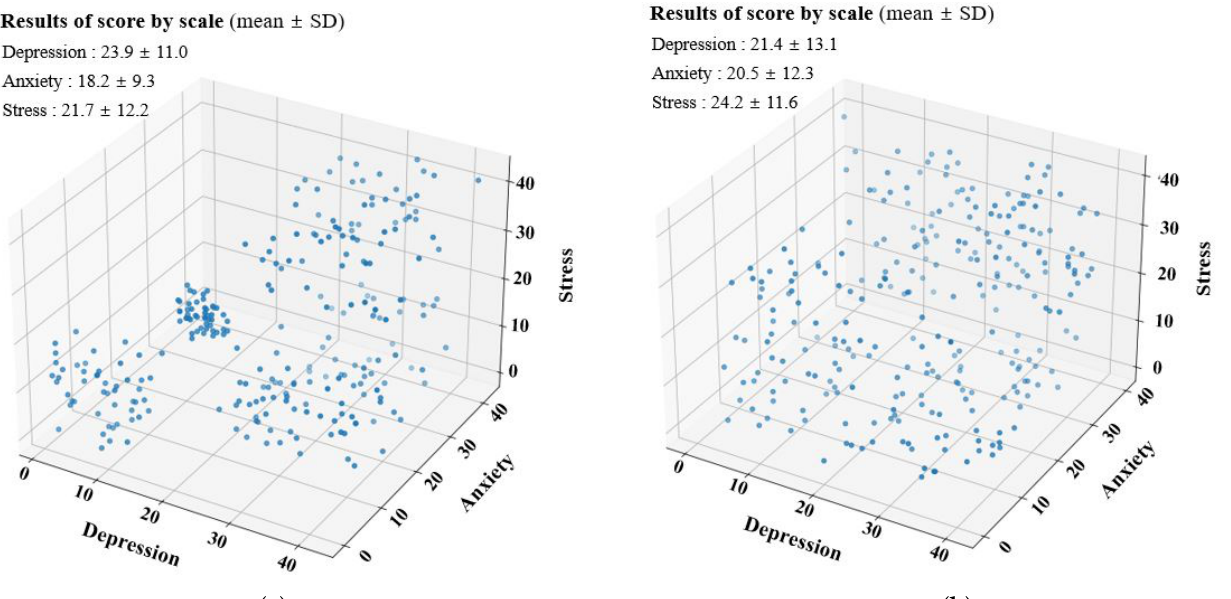
Figure 7. Results of DASS-21 scores by samples. ( a ) Sampling with severity ratio samples. ( b ) Simple random sampling without